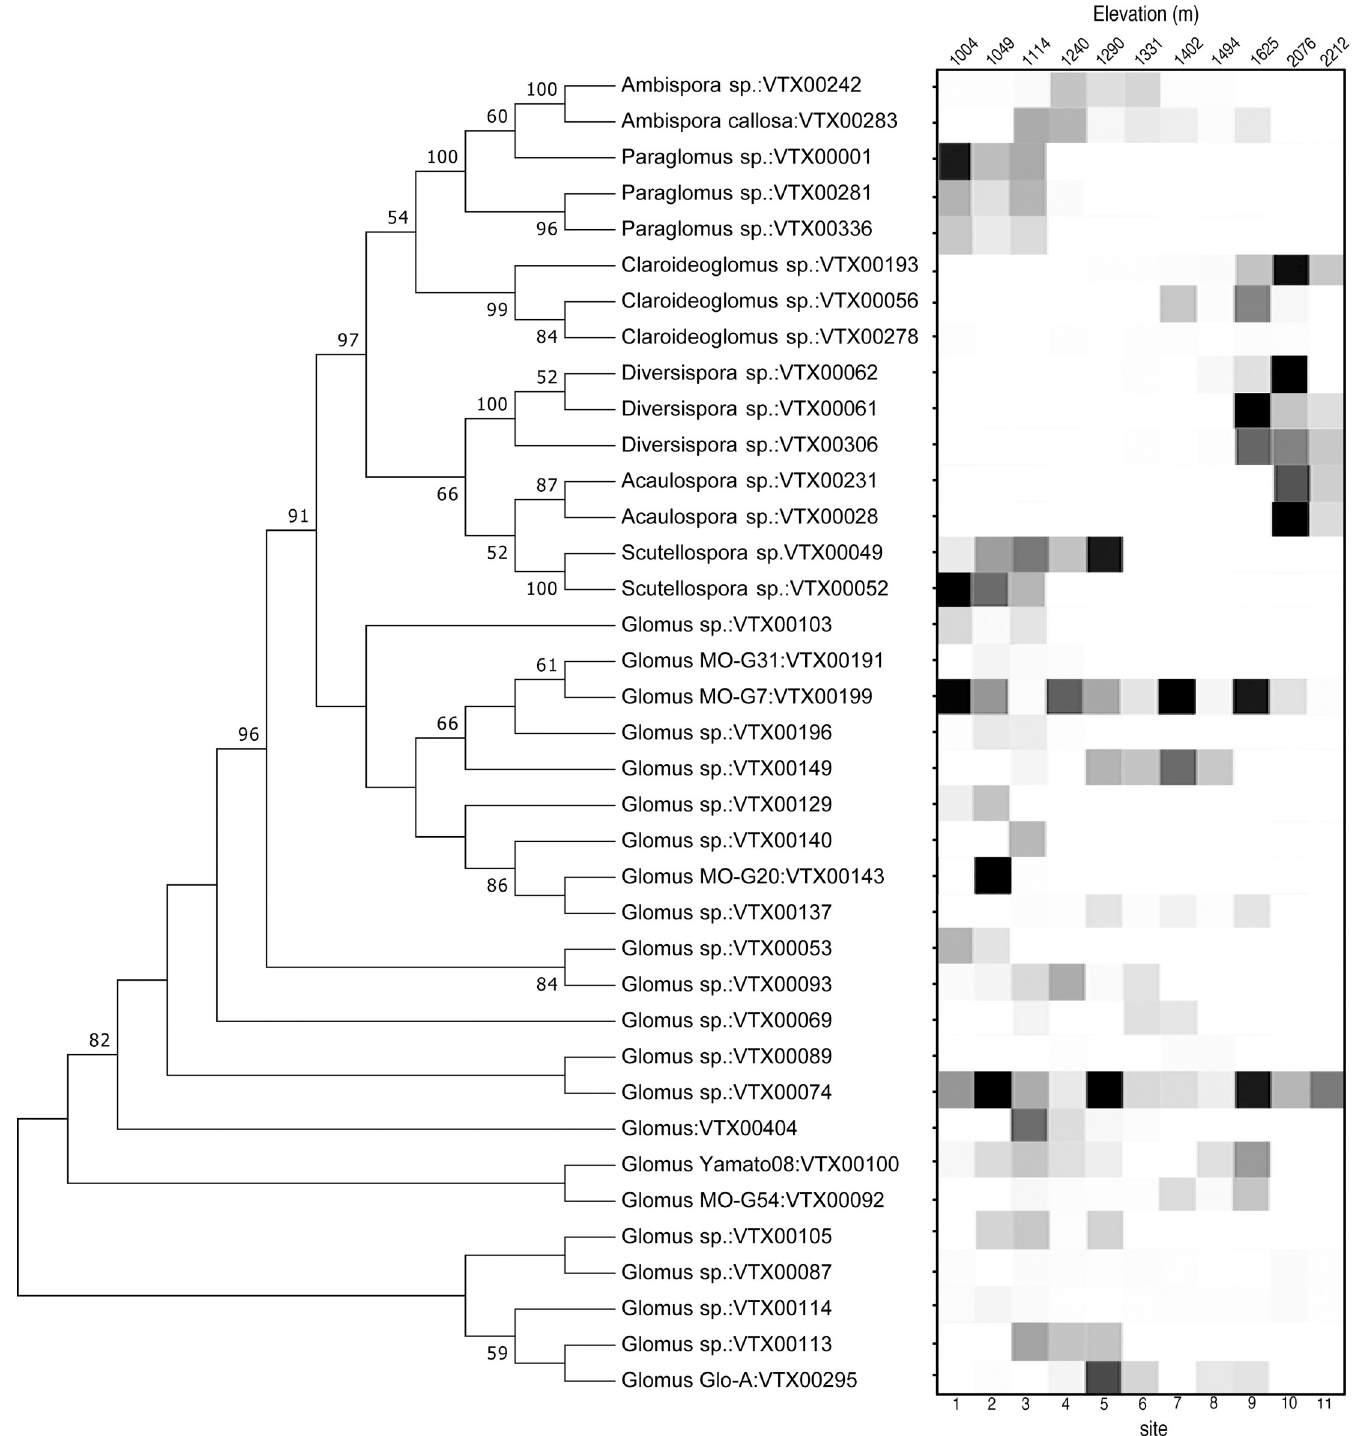
Fig 3. Bootstrap consensus tree and heatmap of the relative abundances of each AMF virtual taxon (VT) across the elevation gradient in Joshua Tree National Park, CA, USA. The tree was built using the Maximum Composite Likelihood method [55] and evolutionary analysis conducted in MEGA7. Node numbers represent Bootstrap values with only those values above 50 displayed. Tips represent AMF species name and VT as they are listed in the MaarjAM database. For the heatmap, rows represent the presence of AMF and the darkness of square indicates the read abundance expressed on a scale from 1–10 of each VT shown on the tree, at each elevation